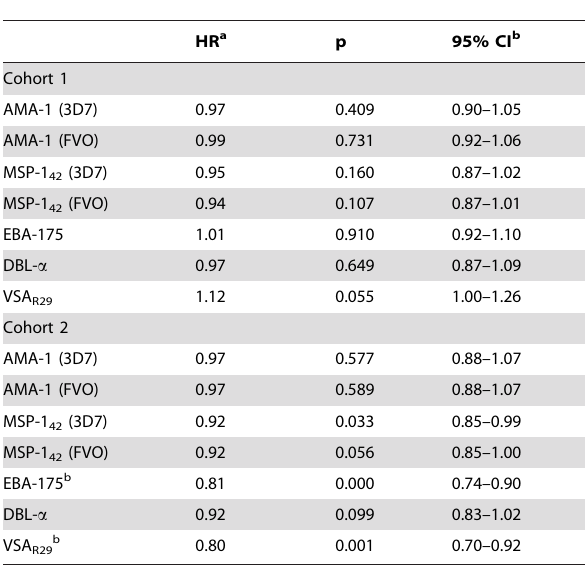
Table 3. Cox proportional hazards model showing effect of IgG levels on risk of having a clinical malaria episode from 6– 18 months